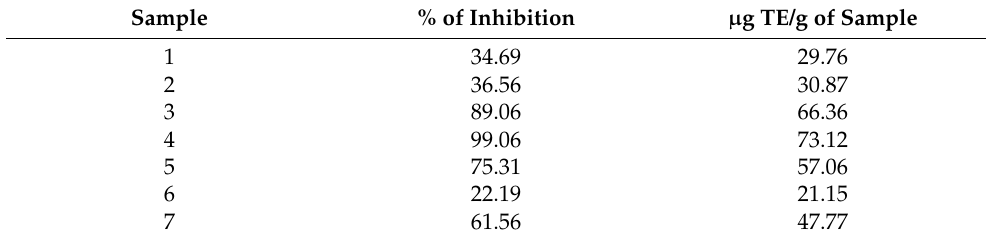
Table 15. Results expressed as percentage of inhibition and in µ g TE/g of sample (ABTS method).